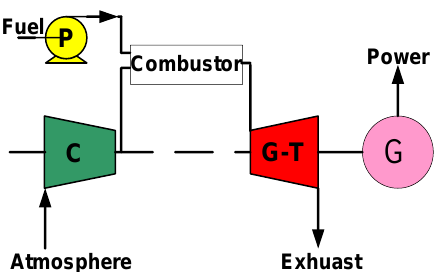
Figure 4. Schematic diagram of gas turbine plant (C—Compressor, G-T—Gas turbine, G—Generator, P—Pump, R—Reservoir).